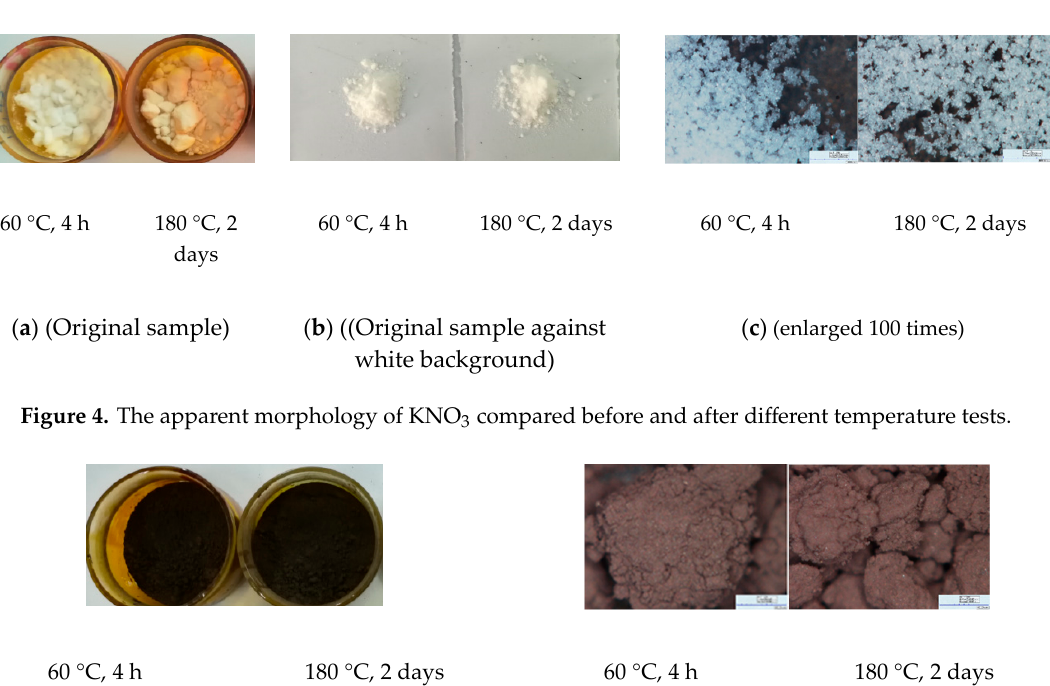
Figure 5. The apparent morphology of boron compared before and after different temperature tests.